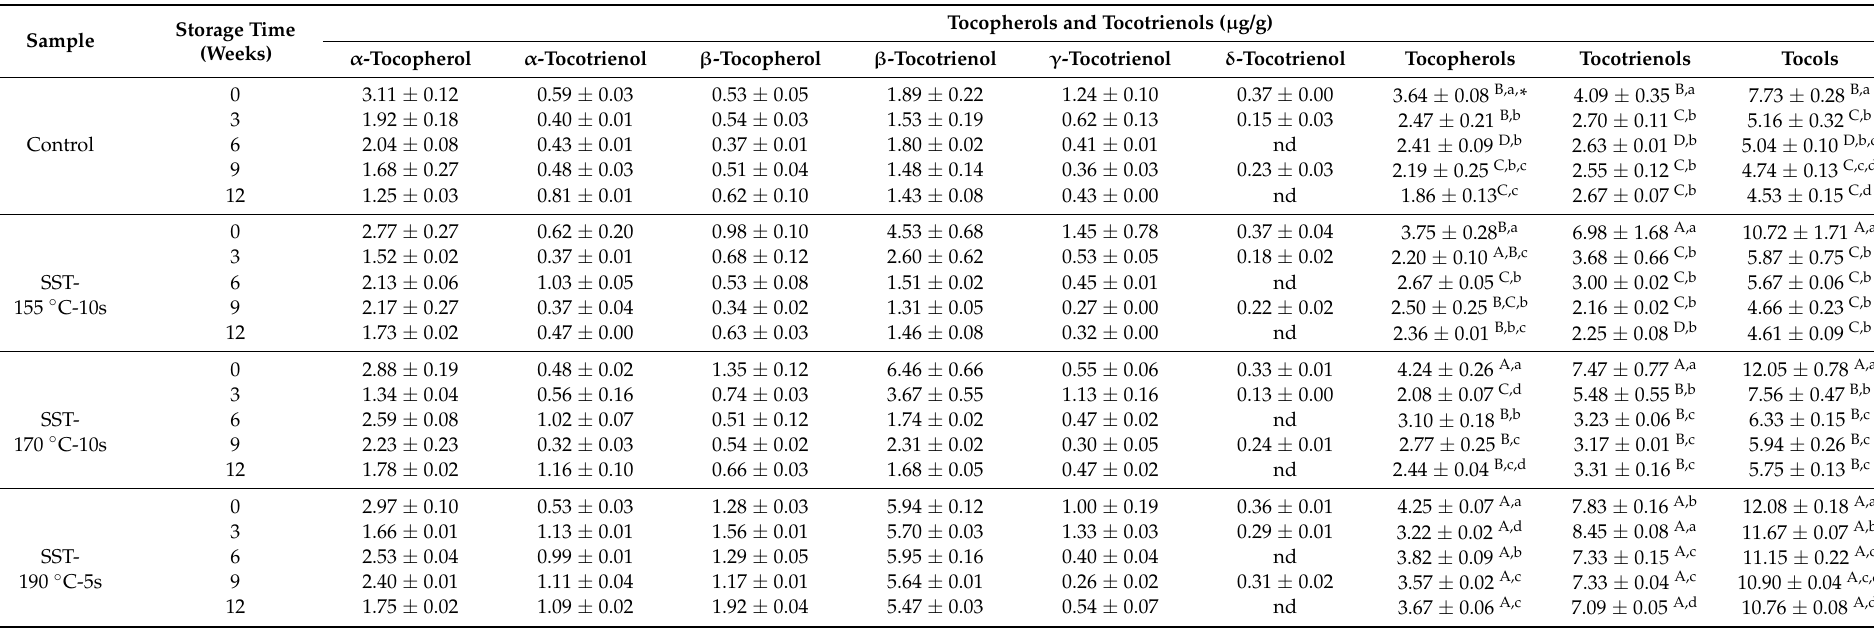
Table 5. Effect of superheated steam treatment on the content of tocopherols and tocotrienols ( µ g/g) in dried whole wheat noodles during storage (mg/g flour, mean ± standard deviation, n =